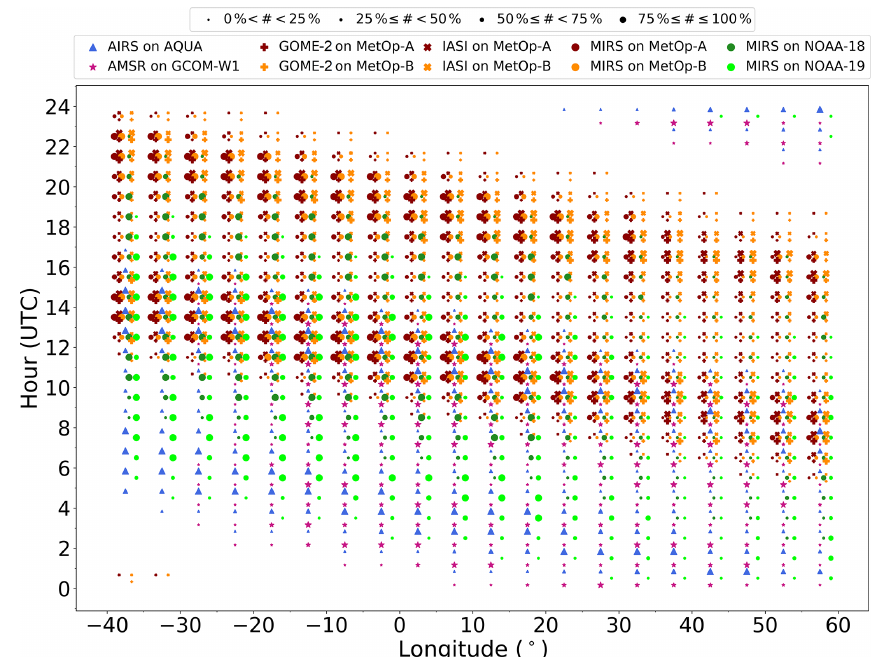
Figure 3. Overview of satellite data sampling for a latitude band (70–80 ◦ N) as a function of time of day and longitude (5 ◦ resolution). For each bin (1h, 5 ◦ ) the total number of measurements over the 2-month period (May–June 2017) is indicated per instrument by the size of the corresponding symbol in quantiles. The maximum number of samples per bin is about 2000 for AIRS on Aqua, 8000 for each IASI platform and about 10000 for the MIRS products on each